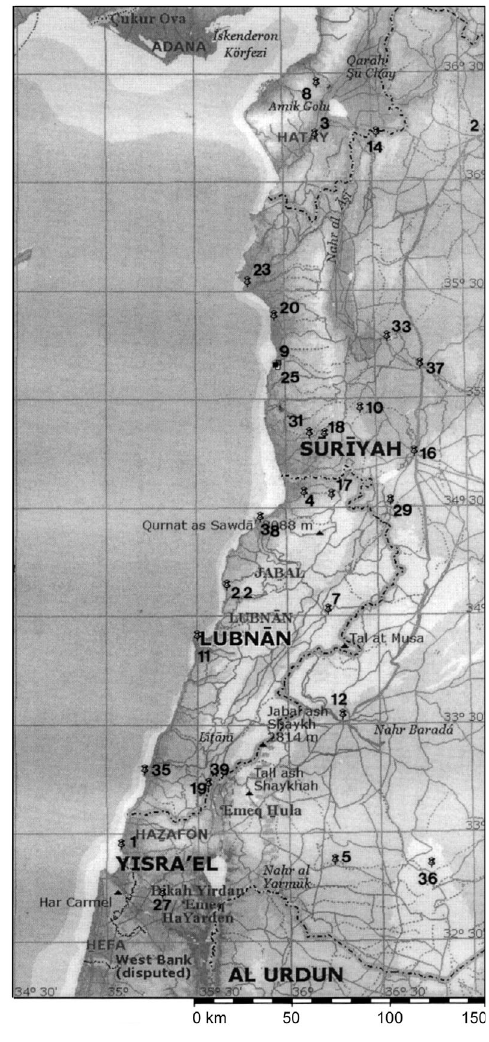
Fig. 6. Location map of the earthquake of 1170. 1 – Acre; 2 – Aleppo; 3 – Antioch; 4 – Arqa; 5 –